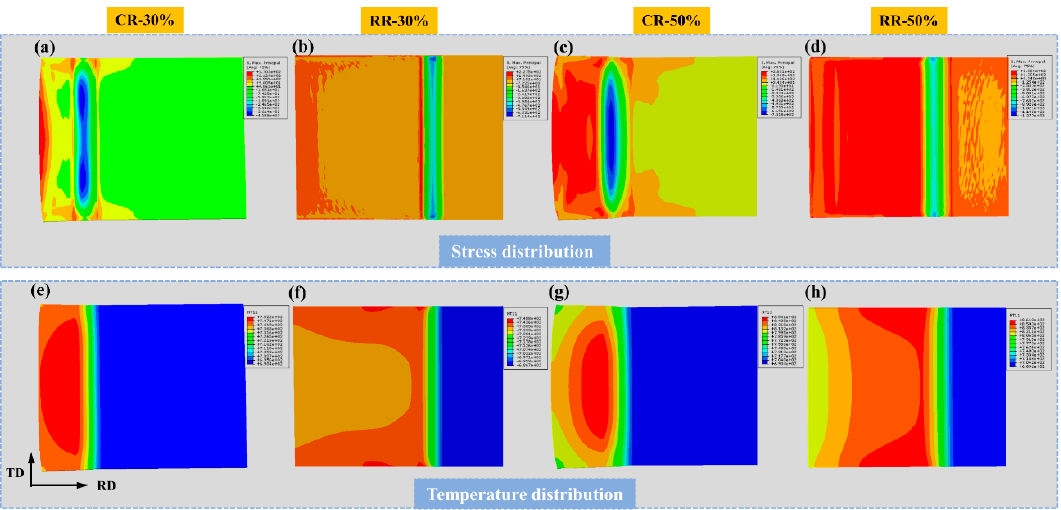
Figure 12. The stress distribution and temperature distribution of ( a , e ) CR30%, ( b , f ) CR50%, ( c , g ) RR30%, and ( d , h ) RR50% plates.